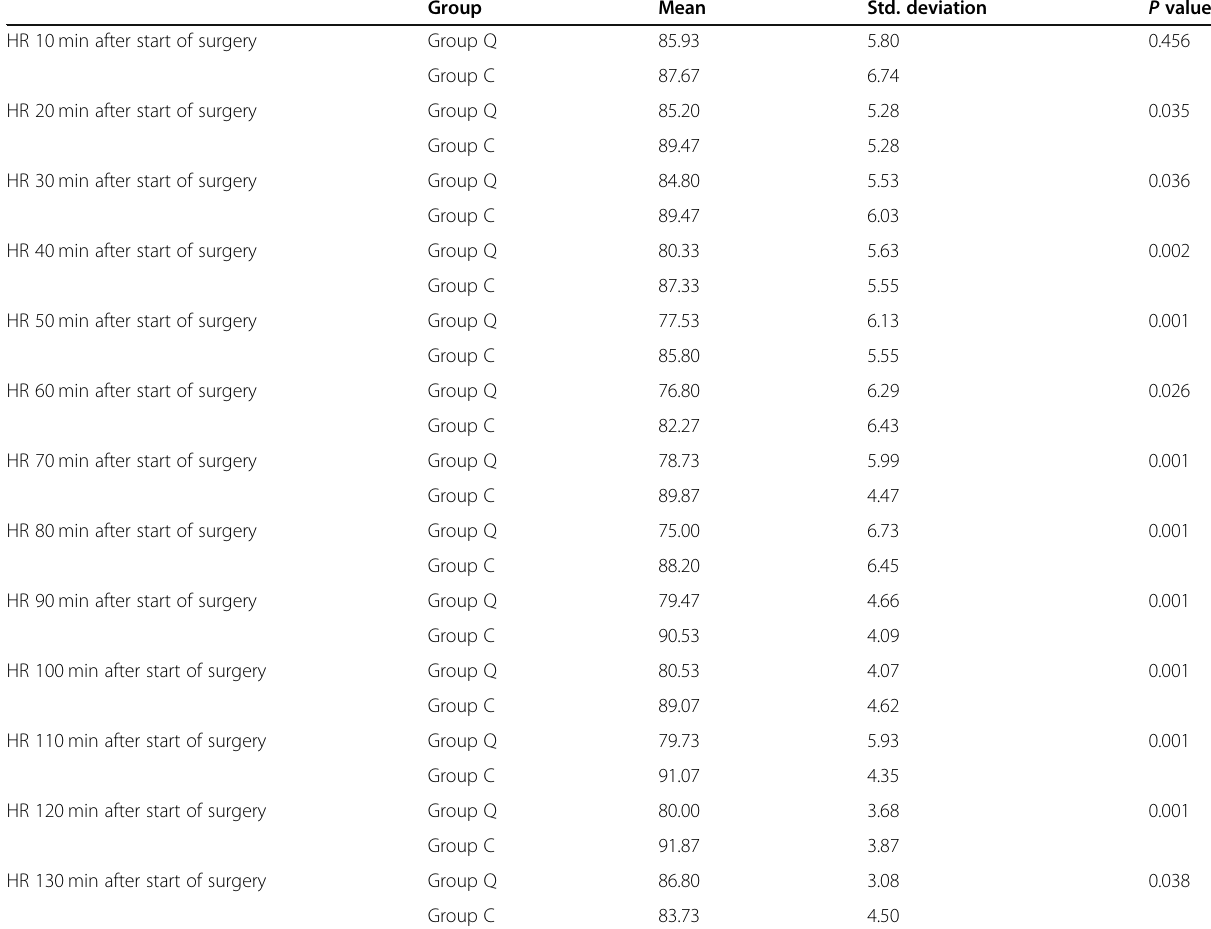
Table 2 Comparison between heart rate in the control (C) group and the QLB (Q) group